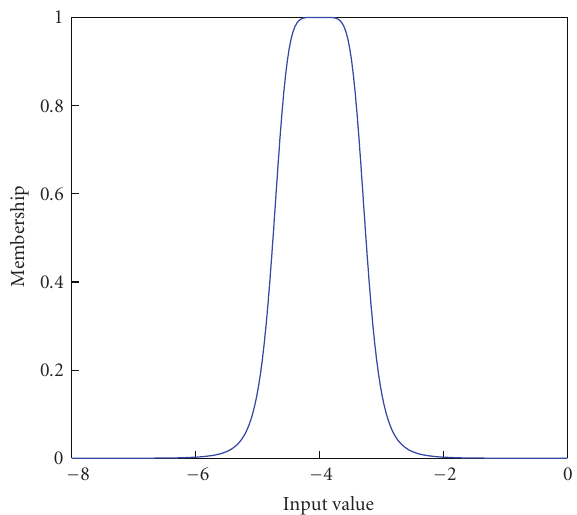
Figure 7: Fuzzy membership function used to determine points of interest from raw geophysics data. MATLAB function: gbellmf( x , [0 . 75,3, − 4]).